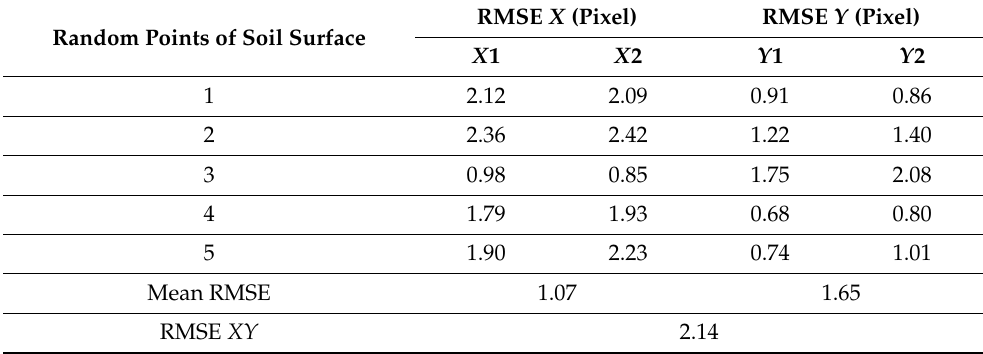
Table 1. RMSE values for 5 random points from the plowed soil surface in the 3D reconstructed image. Random Points of Soil Surface